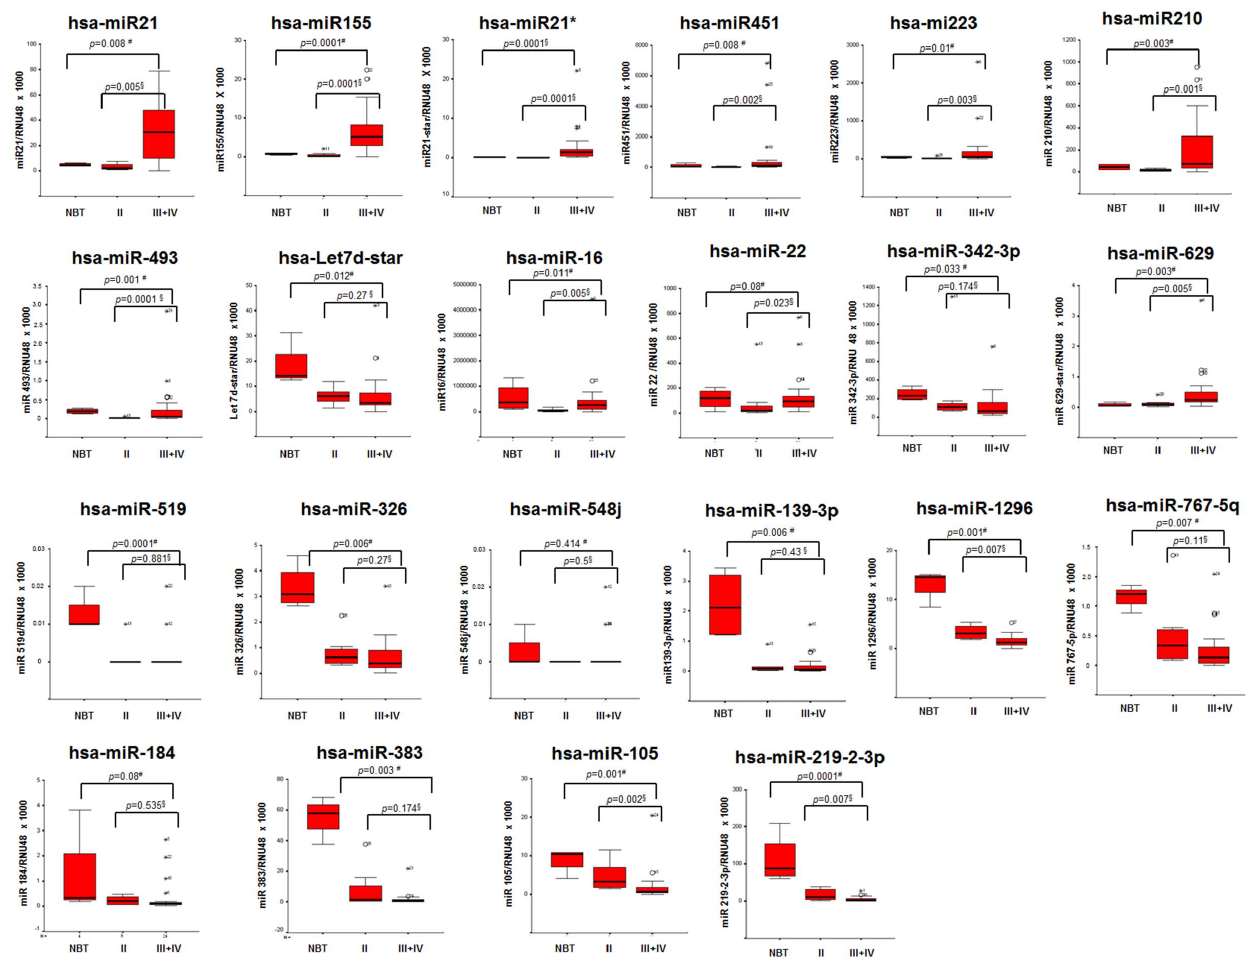
Figure 2. Validation of microarray data by qRT PCR analysis. The 32 glioma samples and 4 NBT were analyzed by RT-qPCR for the expression of the 22 miRNAs identified by microarray profiling. Boxplots of miRNAs expression in normal brain tissues (NBT), WHO grade II gliomas (II) and WHO grade III and IV gliomas (III + IV). Expression levels are expressed as: target miRNA/RNU48 multiplied by 1000. The boxes mark the interquartile range, (interval between the 25th and 75th percentile). The lines inside the boxes denote median values, the symbol * denote the outliers. # NBT vs II vs III + IV comparison by Kruskall Wallis Test; 1 II vs III + IV comparison by Mann Whitney test.